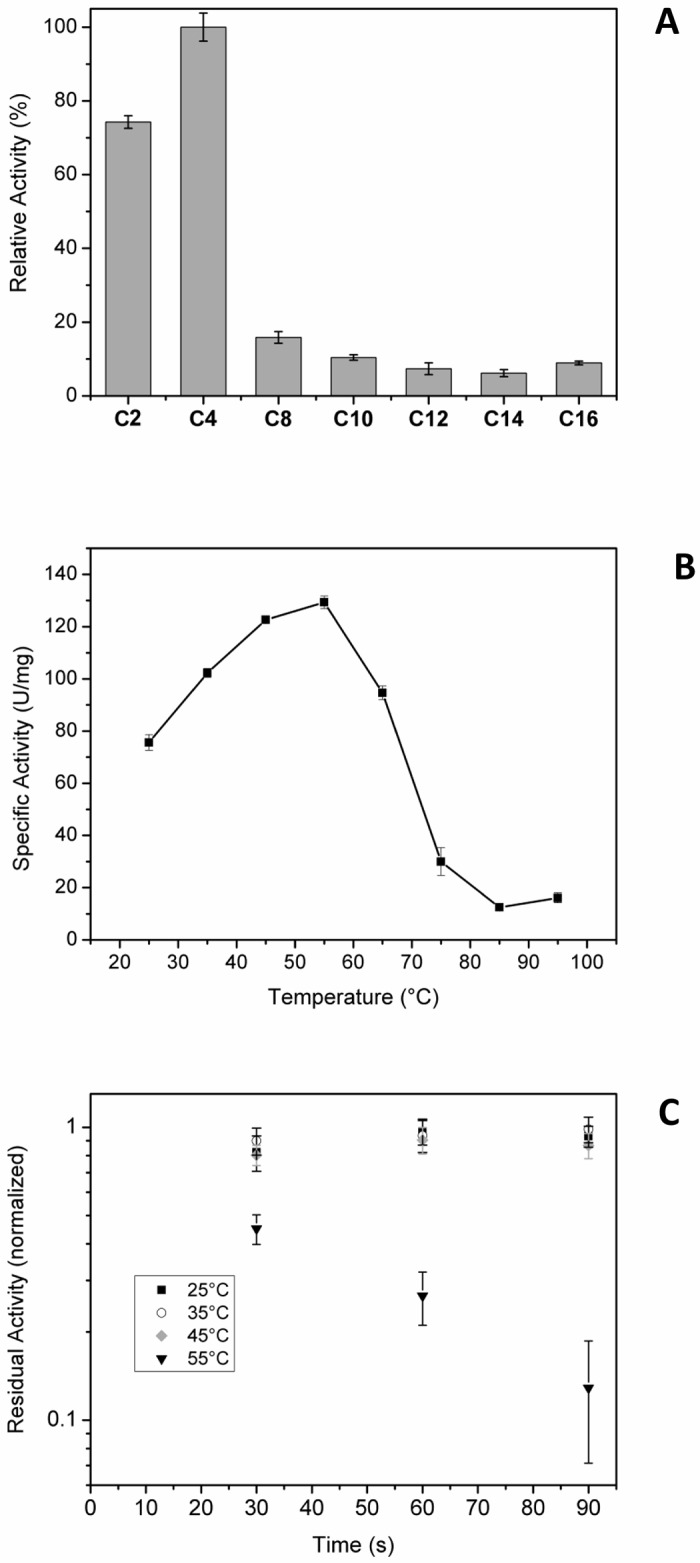
Esterase activity assays.a) The relative hydrolytic activities of PmEst on substrates with different acyl chain sizes were calculated with respect to C4. b) Determination of the optimum temperature of PmEst on pNB, and c) Residual activity normalized as a function of pre-incubation time at 25, 35, 45 and 55°C. PmEst was inactive when pre-heated at temperatures higher than 55°C. Error bars represent the standard deviations from the triplicate measurements.